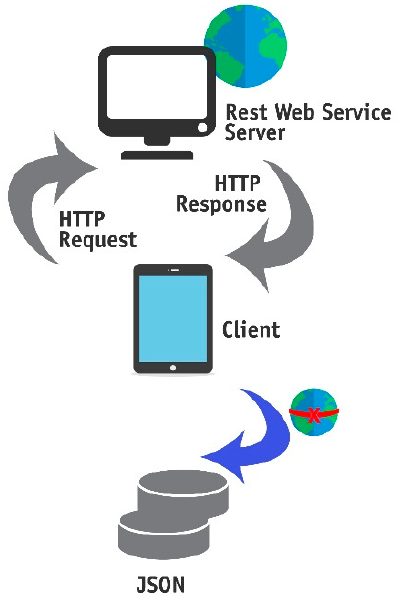
Figure 1. Software architecture.